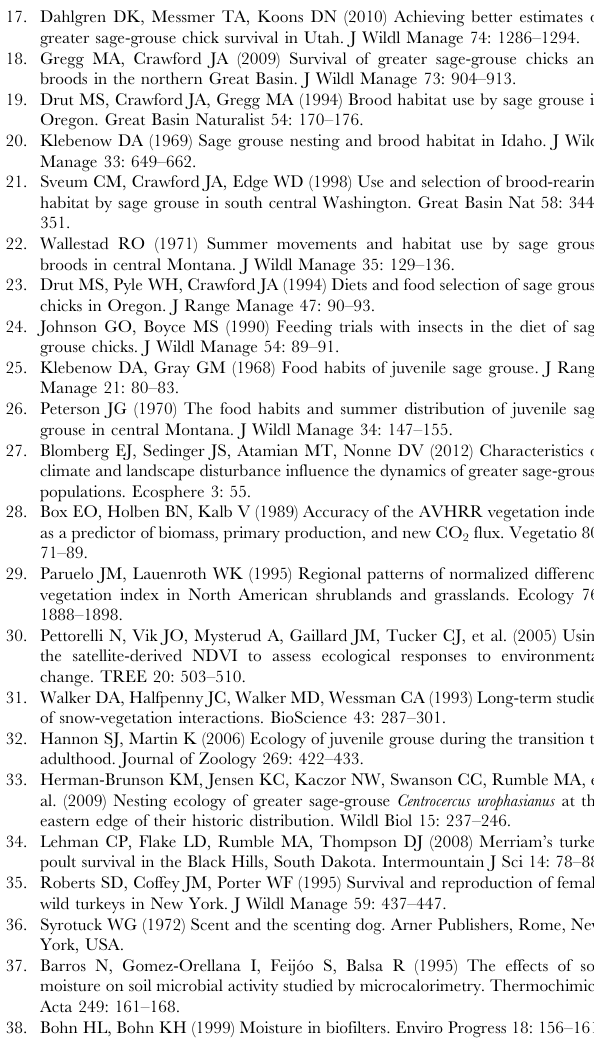
greater sage-grouse chick survival. Confidence intervals were calculated based on 5,000 bootstraps of the original data set. Table S9 Evaluation of the effects of site and year effects on the top model from Table S7. All models contain the base effects of quadratic chick age and hen age. Models were evaluated using the Quasi-Akaike’s Information Criterion (QAIC). K = number of parameters. w i =model weight (i.e. the likelihood of a particular model being the best